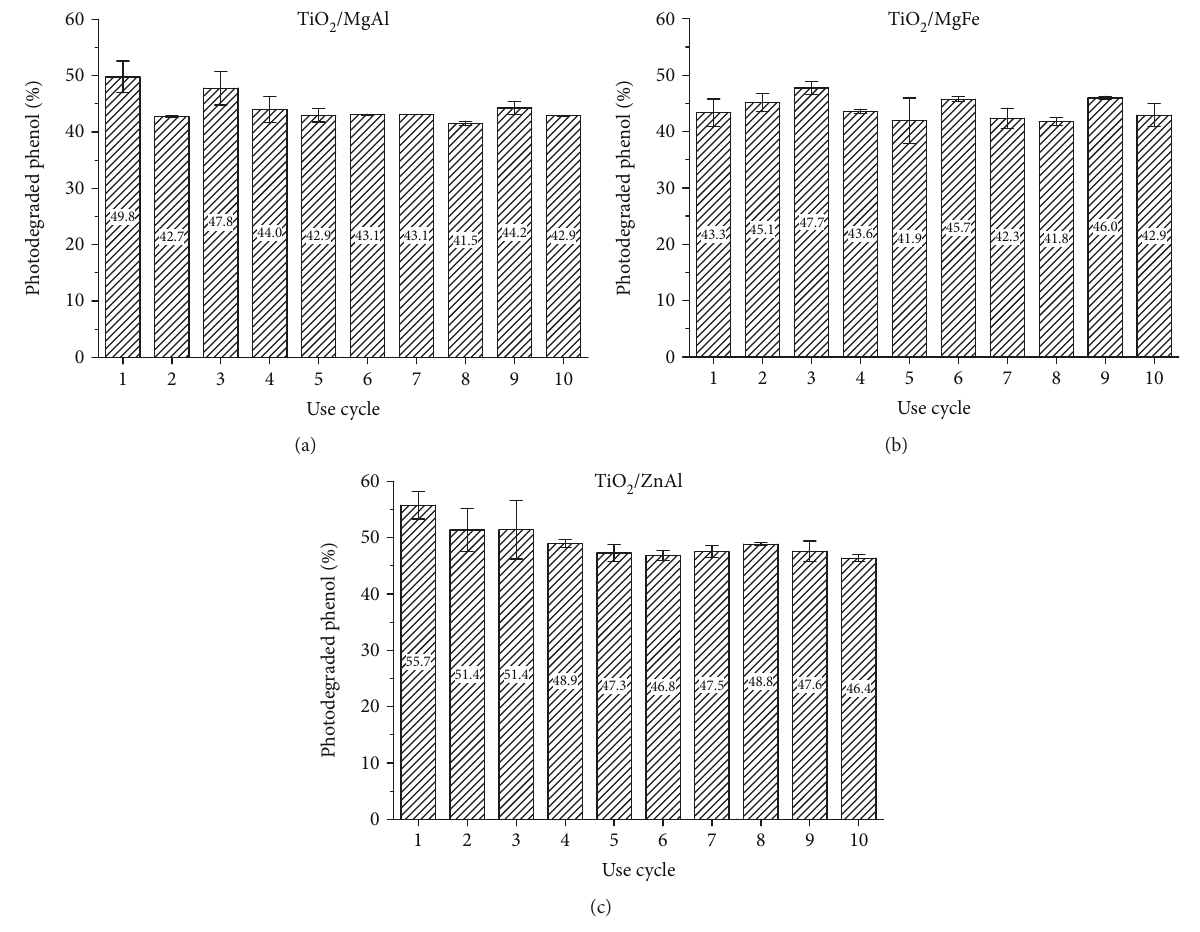
Figure 9: Reuse of TiO